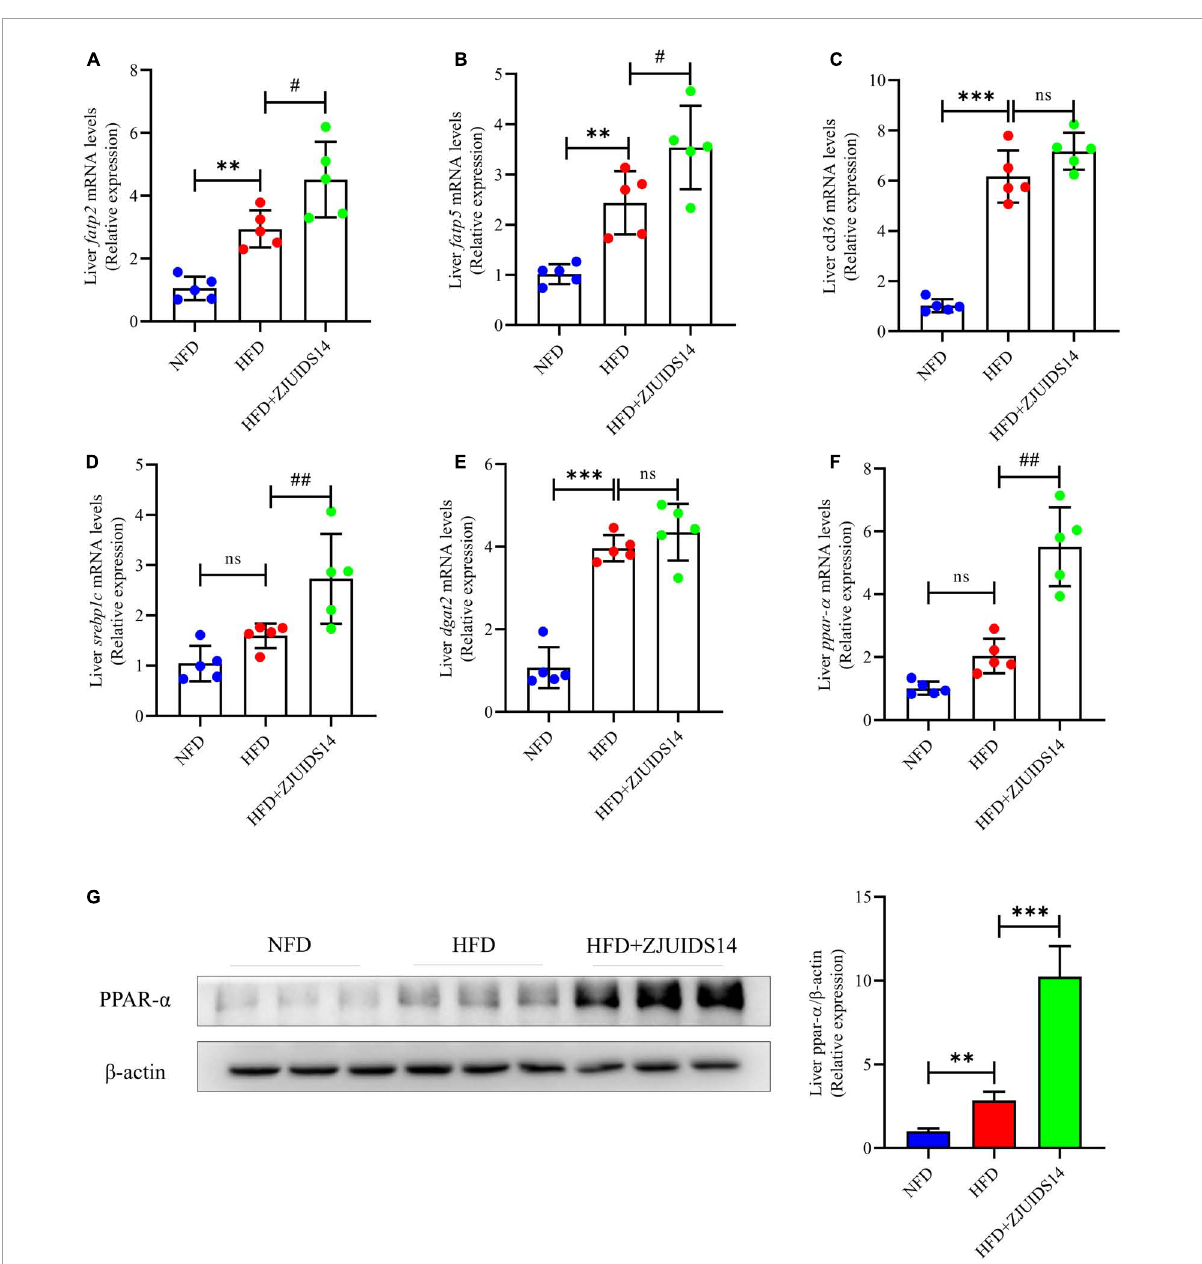
FIGURE4 Lactobacillus plantarum ZJUIDS14 administration inhibits hepatic steatosis in HFD fed mice. Hepatic mRNA expressions of (A) fatp2 , (B) fatp5 , (C) cd36 , (D) srebp1c , (E) dgat2 , (F) ppar- α , (G) protein expression of PPAR- α . ∗∗ P < 0.01, ∗∗∗ P < 0.001 vs NFD group; # P < 0.05, ## P < 0.01 vs HFD group. ns, not